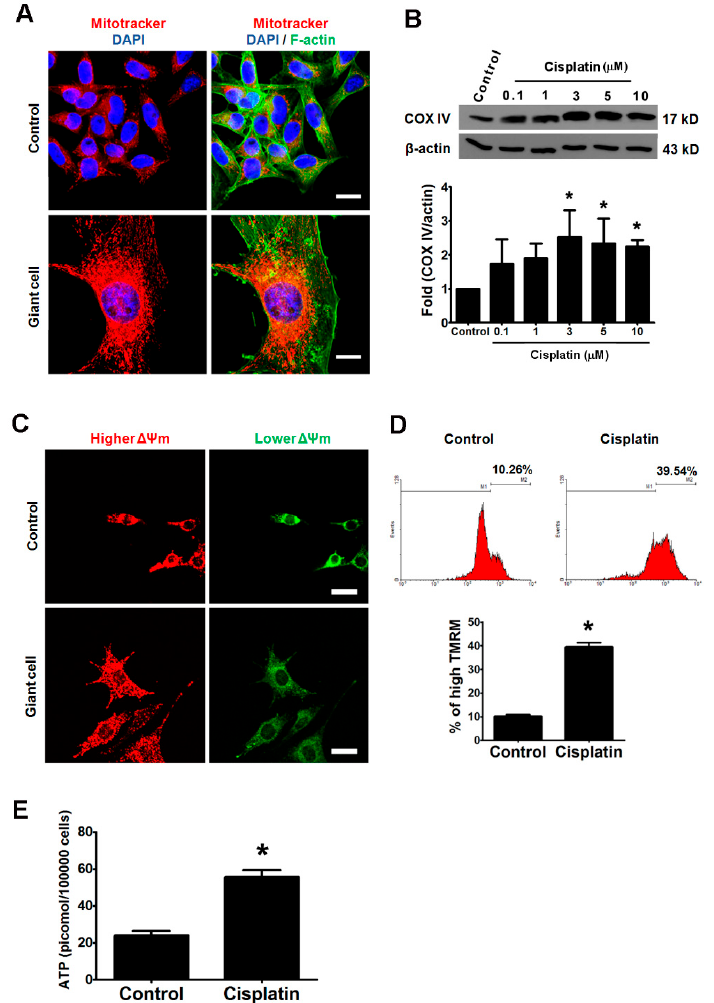
Figure 7. The cisplatin-induced giant cells exhibited high mitochondrial activities and high levels of ATP. ( A ) The formation of giant cells was induced by cisplatin in B16-F10 cells, and the amount of mitochondria was monitored. The control cells and the cisplatin-treated cells were co-stained with three dyes to analyze di ff erent cellular organelles: MitoTracker (red) for the mitochondria, phalloidin (green) for F-actin, and DAPI for the nuclei (blue). Scale bar, 20 μ m. ( B ). The amounts of COX IV were increased in B16-F10 cells after 48-h treatment with different doses of cisplatin. The COX IV/ β -actin immunoband intensities were determined by densitometric scanning. ( C ) The mitochondrial membrane potential ( ΔΨ m) was measured by using the JC-1 dye. A red color indicates a relatively high membrane potential, whereas a green color indicates a relatively low membrane potential. The giant cells displayed higher red fluorescence and lower green fluorescence. Scale bar, 50 μ m. ( D ) The mitochondrial membrane potential was measured by TMRM dye, and was analyzed by flow cytometry (top panel; the X axis represents TMRM intensity; the Y axis represents cell count). The percentage of high TMRM population indicated on the panel are the means of three independent experiments. The bar chart displays the percentages of the population with a higher mitochondria membrane potential (bottom panel). ( E ) The cellular ATP of an equal number of control and cisplatin-treated cells was measured by a luciferin-luciferase bioluminescence method. * p < 0.01 compared with the control